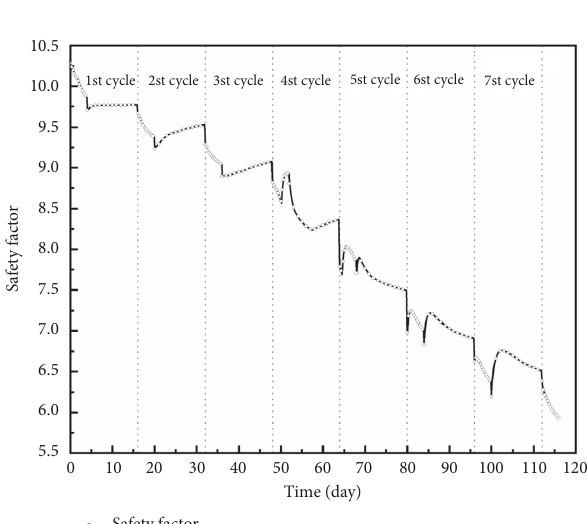
Figure 4: Slope safety coefficient change curve with